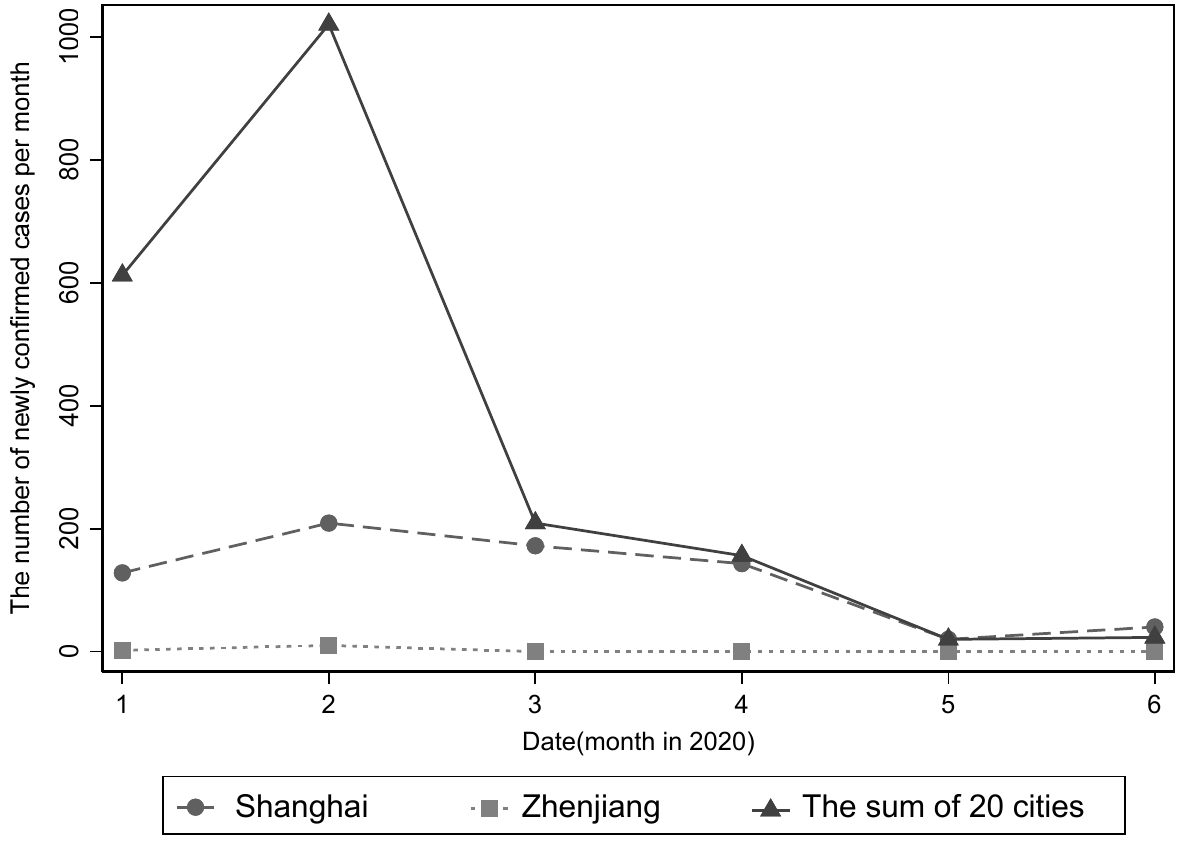
Figure 1. The severity of COVID-19 in Yangtze River Delta.